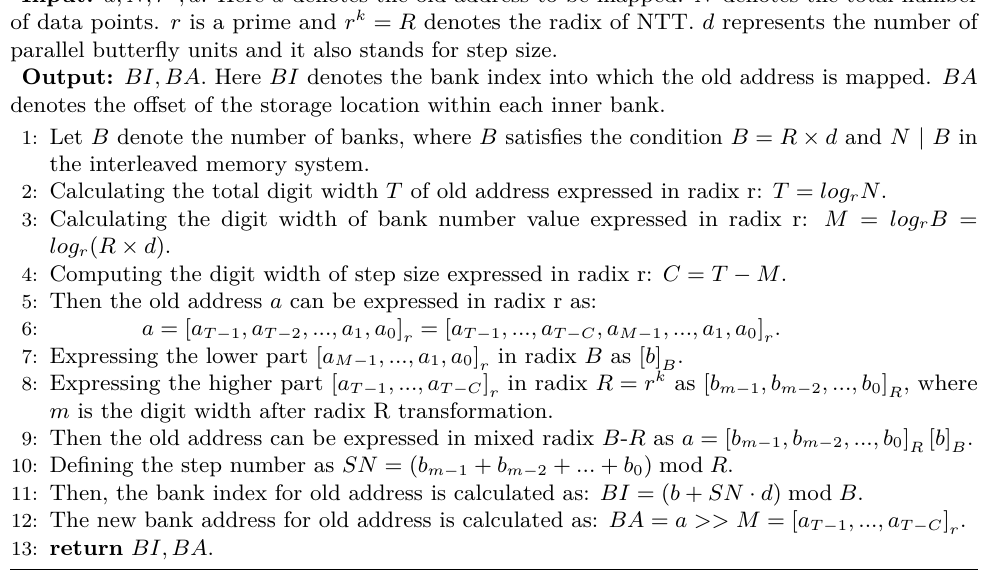
Figure 6: The data flow of 8 points radix-2 DIT-NR NTT. Algorithm 7 Conflict-free memory mapping scheme for arbitrary radix in-place